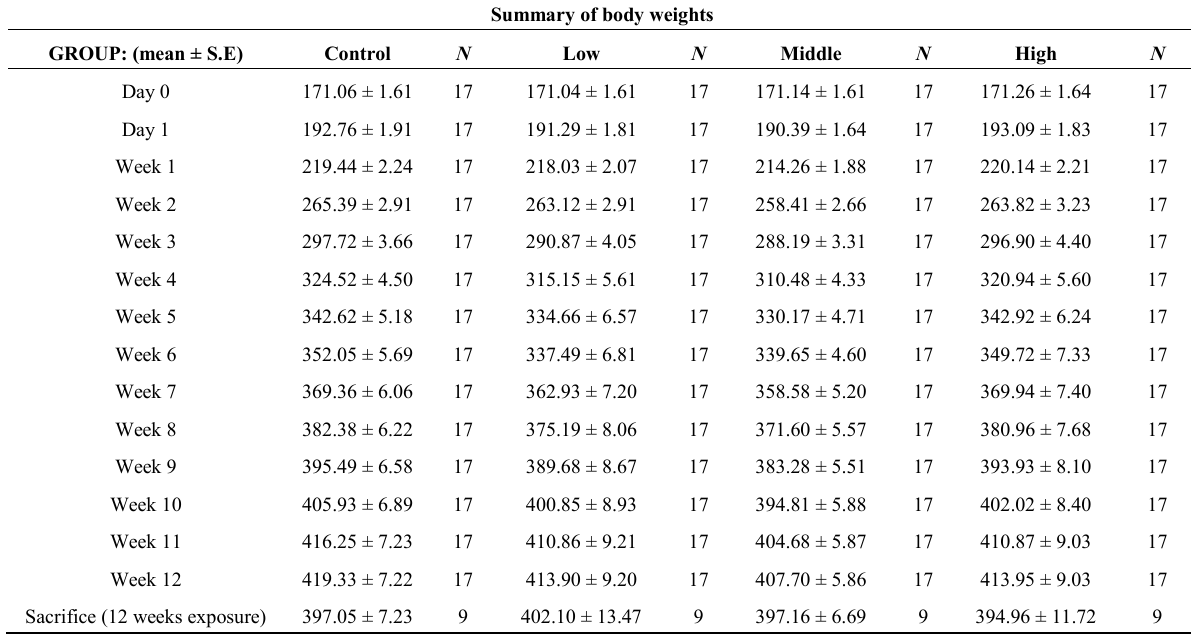
Table 1. Body weight changes for male rats during subchronic exposure to silver